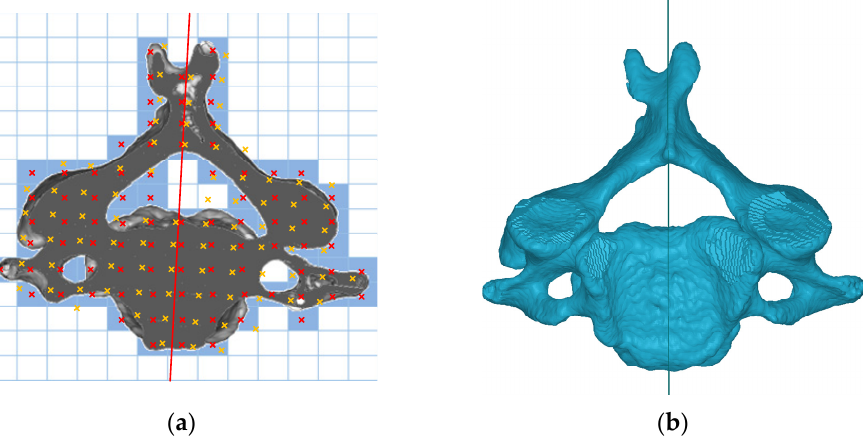
Figure 1. ( a ) Possible symmetry line on a cross-sectional image; ( b ) superior view of a C4 vertebra and its OSP.